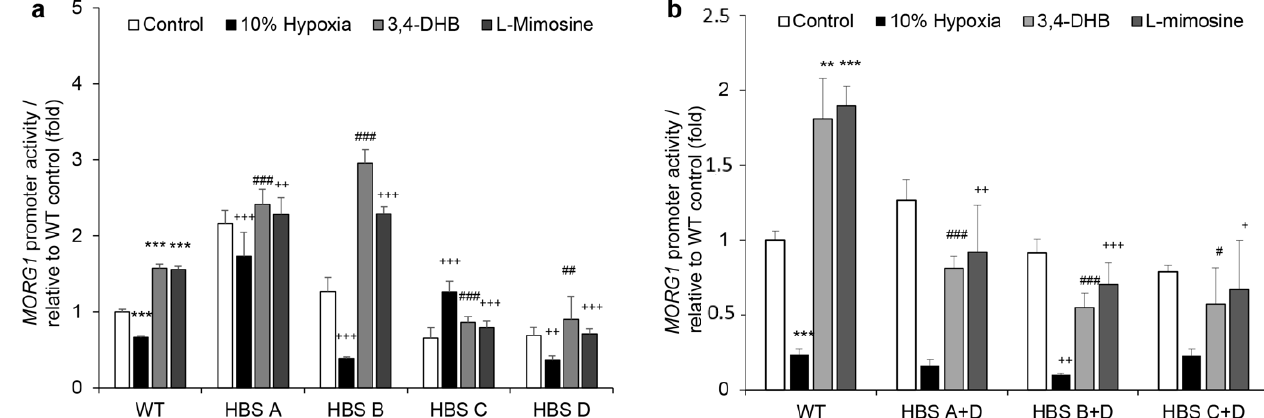
Figure 9. Mutational analyses of the human MORG1 promoter reporter constructs. The influence of the individual HBS on the h MORG1 promoter reporter activity was analyzed by the introduction of mutations in each individual site (single mutants) or at two HBS simultaneously (double mutants).